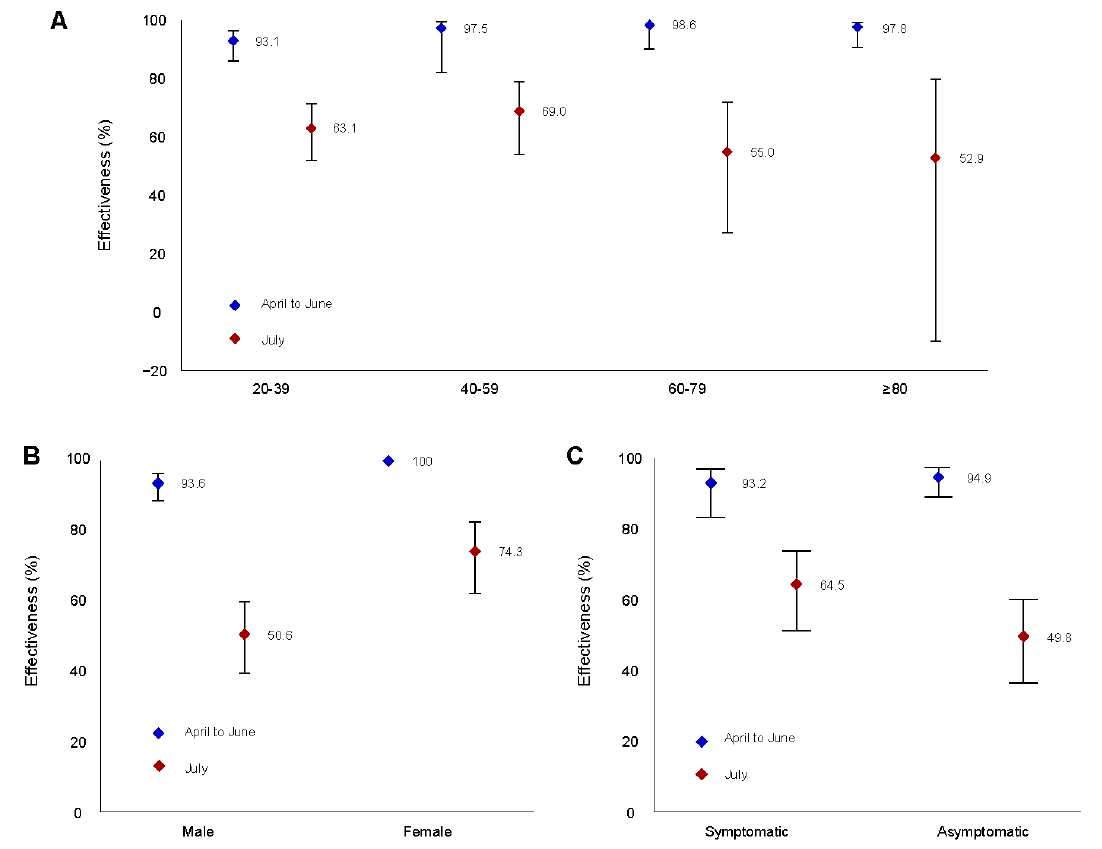
Figure 3. Effectiveness of COVID-19 vaccines against SARS-CoV-2 infection according to age, sex, and symptoms. Estimation of vaccine effectiveness in the pre-delta-dominant period (blue diamonds) and the delta-dominant period (red diamonds) and 95% confidence intervals (vertical bars) according to ( A ) age, ( B ) sex, and ( C ) symptoms. The age groups were divided into 20-year